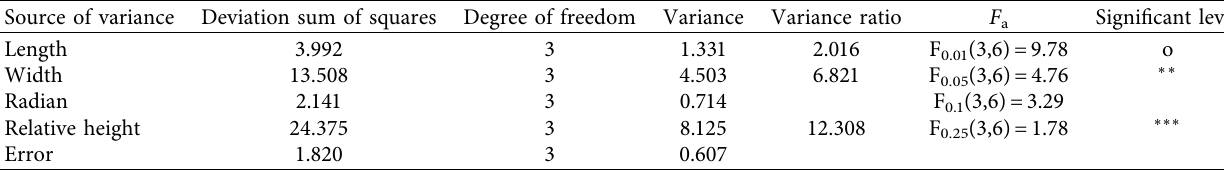
Figure 3: Line graph of the relationship between flow velocity uniformity and various factors. Table 3: Analysis of variance of flow velocity